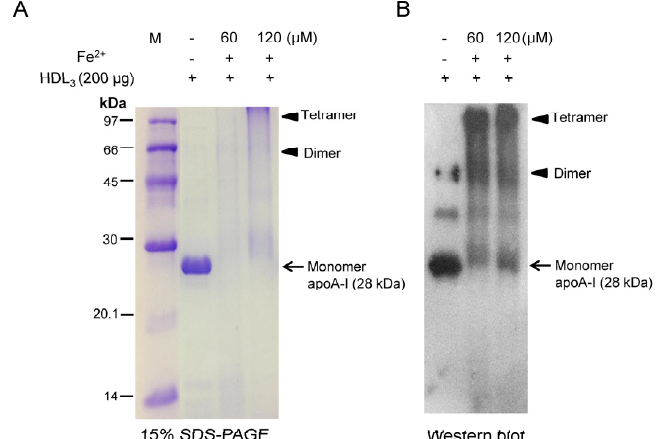
Figure 1. Electrophoretic patterns of human high density lipoprotein (HDL 3 ) after Fe 2+ treatment for 96 h. ( A ) Proteolytic degradation of apoA-I in HDL 3 upon Fe 2+ treatment (15% sodium dodecyl sulfate polyacrylamide gel electrophoresis (SDS-PAGE)). Protein bands were visualized by Coomassie brilliant blue R-250; ( B ) Immunodetection of apoA-I in HDL 3 with apoA-I antibody (ab7613, Abcam). Aggregated and multimerized apoA-I bands were detected up to